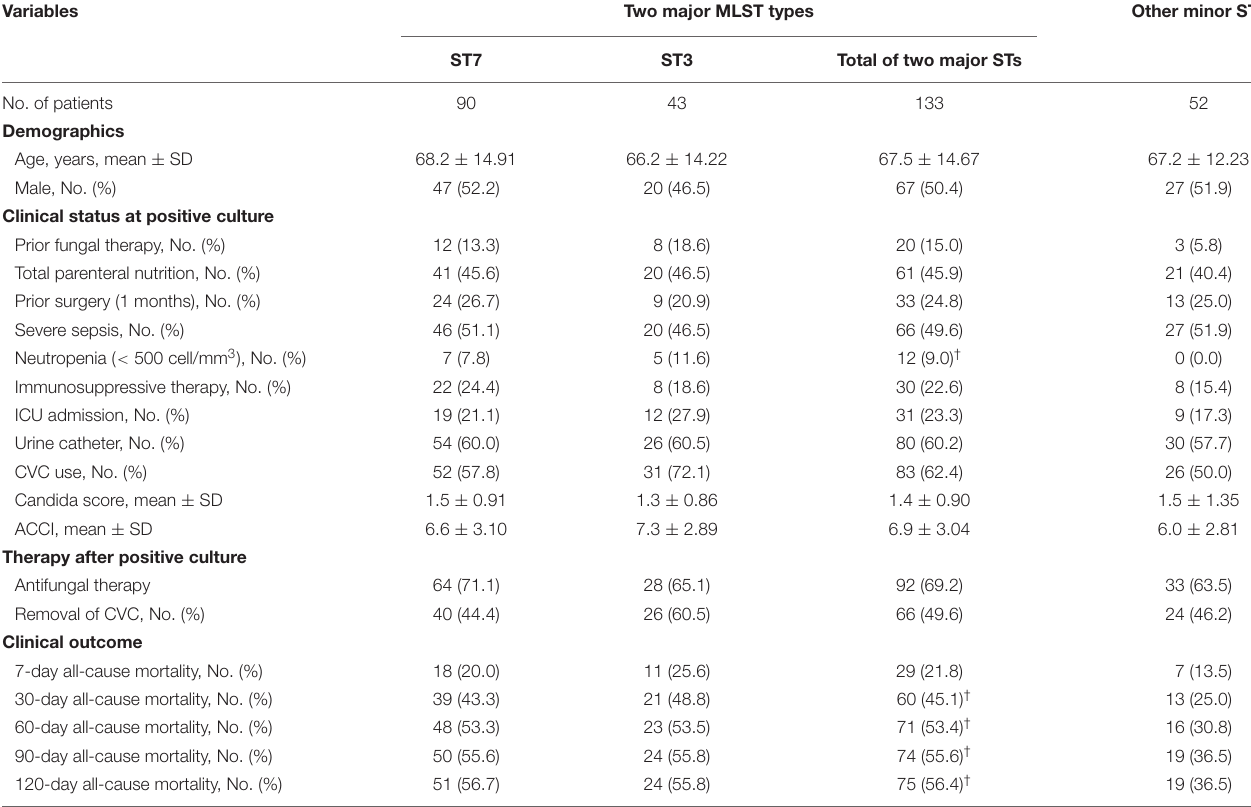
TABLE 3 | Clinical characteristics of C. glabrata bloodstream isolates belonging to two major STs (ST7 and ST3) and other minor STs.